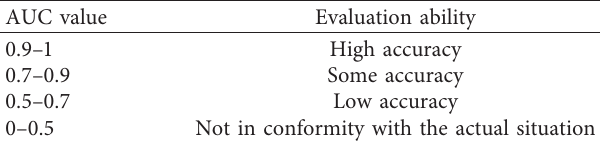
Table 2: Evaluation index of ML model.